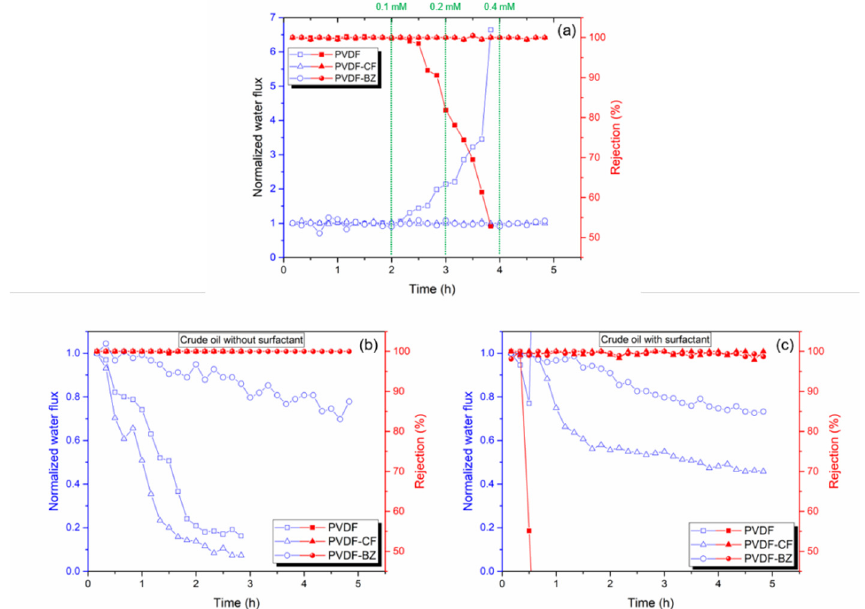
Figure 8. Effect of SDS and crude oil in the feed on membrane performance. ( a ) Antiwetting test of the MD membranes using a range of SDS concentrations. ( b , c ) Antifouling test using 1000 ppm crude oil suspension with/without surfactant solution. The feed and permeate flow rates were 0.86 and 0.35 mL/min, respectively.